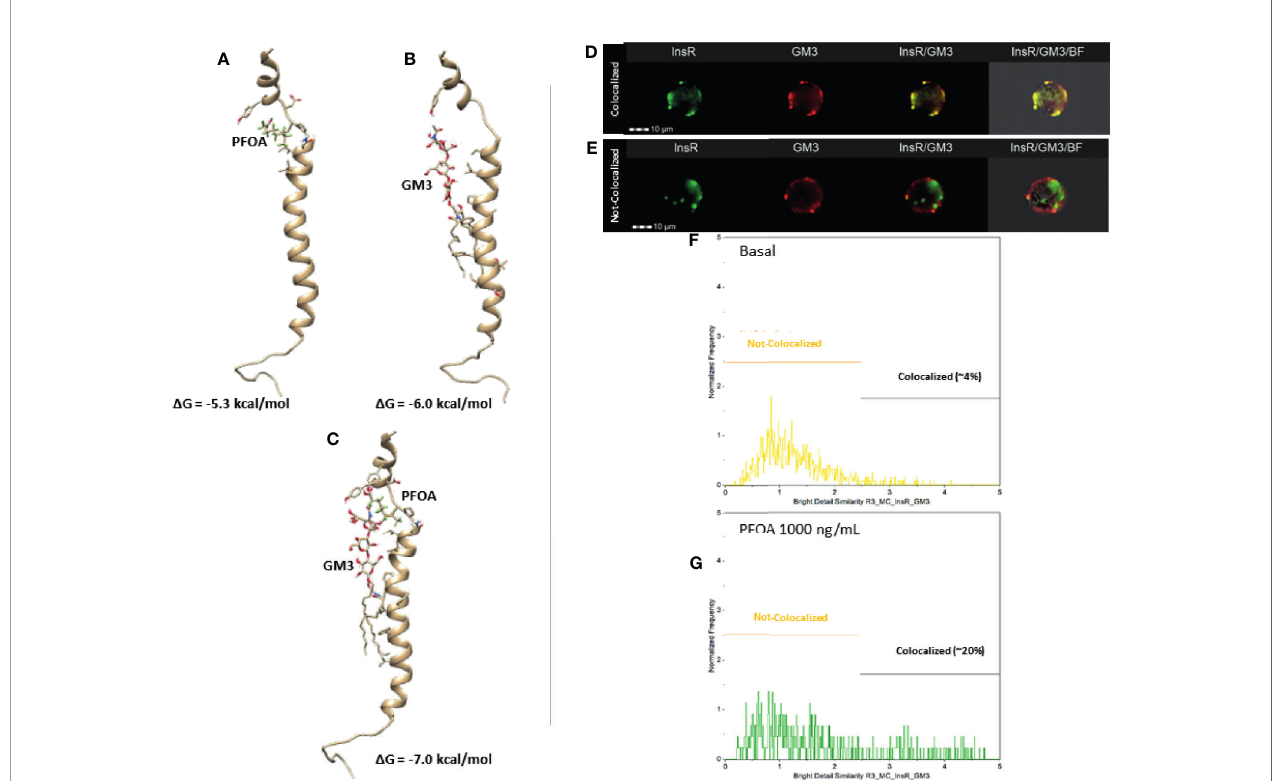
FIGURE 3 | Representative results of the computational docking analysis of per fl uoro-octanoic acid (PFOA, A ), monosialo-dihexosyl-ganglioside (GM3, B ) and both (C) on insulin receptor b -chain. The estimated free Gibbs energy variation ( D G) values associated with the formation of each complex are reported. Staining pattern of Insulin Receptor (InsR, green) and GM3 ganglioside (GM3, red) in HepG2 at basal (D) and after 24 hours exposure to PFOA 1000 ng/mL (E) at Flow Cytometry Imaging analysis. The respective the distribution of the staining co-localization of the two antigens is reported in the histogram plot (F, G) Data are representative of three independent